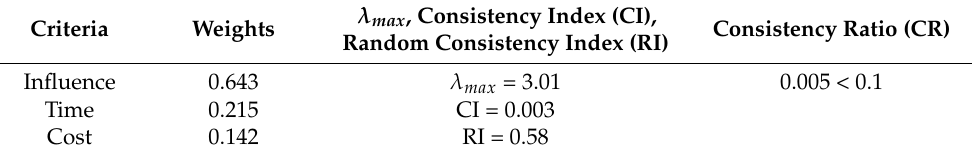
Table 3. Results of the weights.